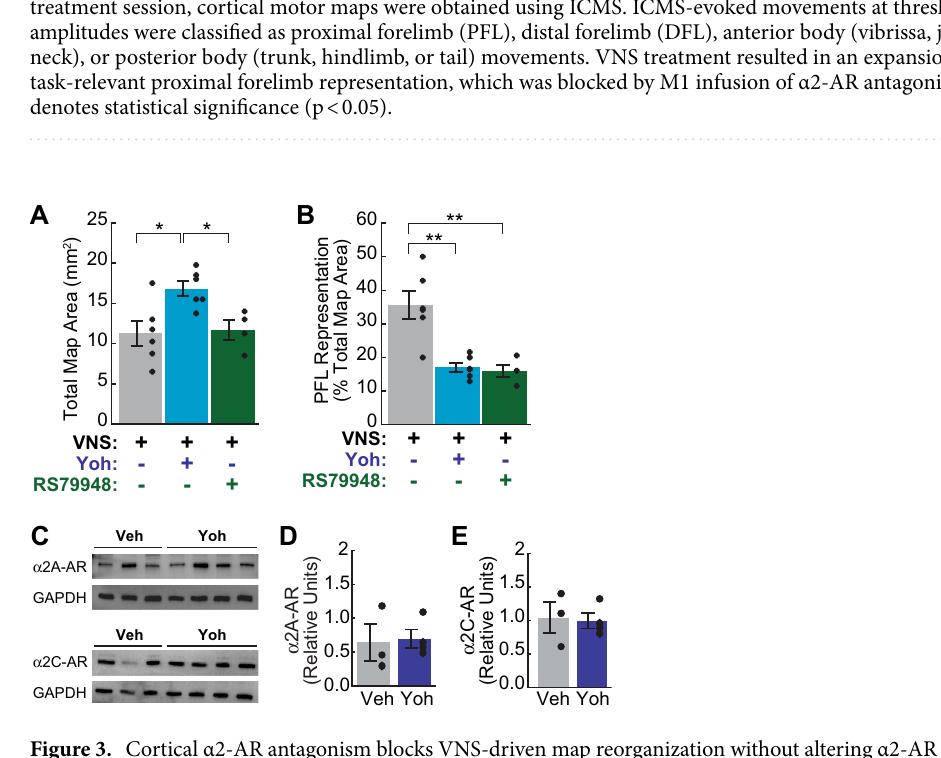
(Fig. 3A; Supplementary Table 3), suggesting that the overall map expansion we observed in the yoh|VNS treat- ment group may be unrelated to α2-AR antagonism. Yohimbine is known to additionally antagonize dopamine D2 receptors and agonize serotonin 5-HT1A receptors 43 , and both catecholamines have been linked to changes in motor map size 48,49 ; these or other off-target effects may contribute to the enlarged maps observed in our yoh|VNS group. RS79948 was found to be as effective as yohimbine at blocking the VNS-induced expansion of